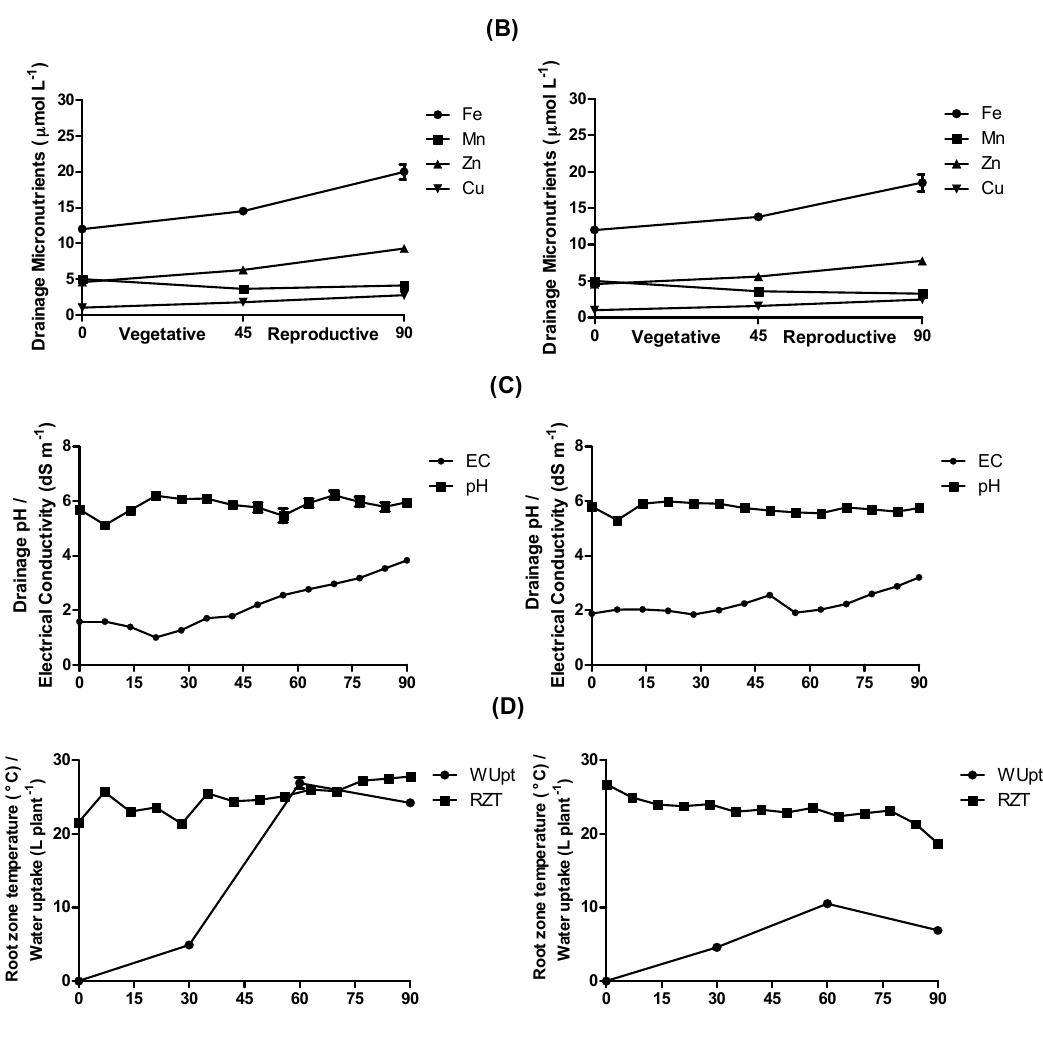
Figure 2. ( A ) Macro-(NO 3 , P, K, Ca and Mg; mmol L − 1 ) and ( B ) micronutrient (Fe, Mn, Zn and Cu; µ mol L − 1 ) concentrations, ( C ) electrical conductivity (EC; dS m − 1 ), pH and ( D ) root zone temperature (RZT; °C) in the recycled drainage solution and water uptake (L plant − 1 ) in two cropping seasons (spring-summer, SS crop; autumn-winter, AW crop) of hydroponic common bean, in relation with time indicating growth stages (Vegetative and Reproductive). Values are means calculated across treatments and vertical bars indicate ± standard errors of means (not shown when smaller than the symbol).